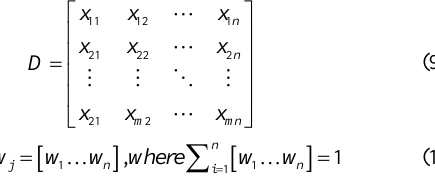
Table1. Selected Criteria and its Alternatives